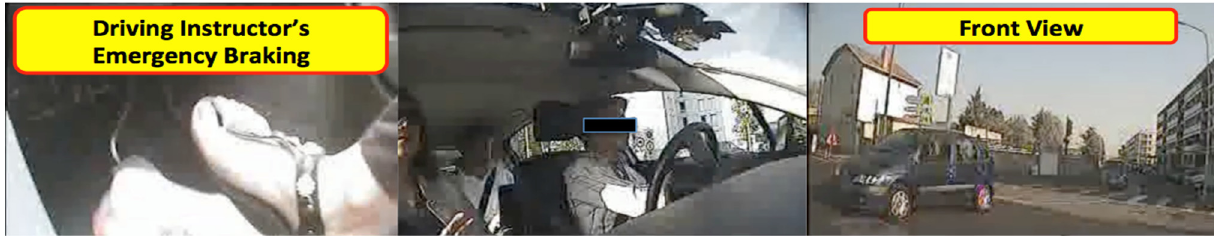
Figure 2. Example of a typical errors made by vulnerable car drivers when implementing a left-turn manoeuver at urban crossroads.